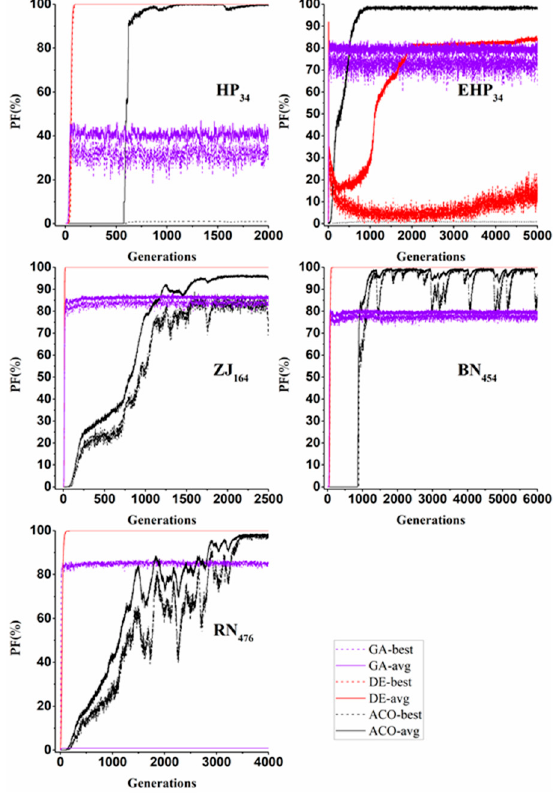
Figure 4. Solution quality metric PF% of the three different types of EAs applied to the five case studies.